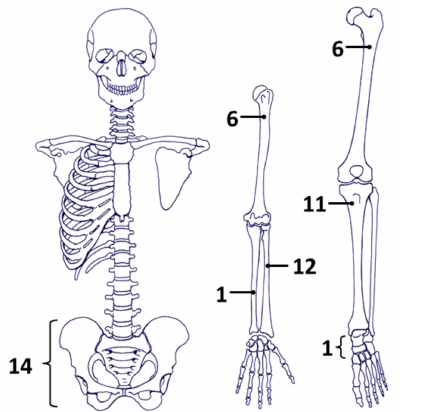
Figure 2. Anatomical site distribution of the 51 GCTB in the 51 patients